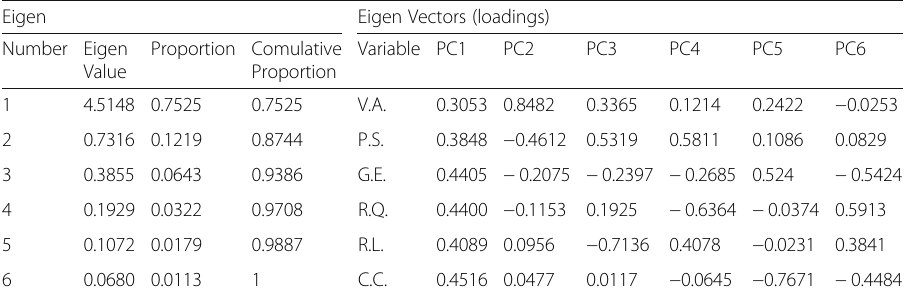
Table 4 Result of principal component analysis showing eigen values and eigen vectors Eigen Eigen Vectors (loadings) Number Eigen Proportion Comulative Variable PC1 Value Proportion